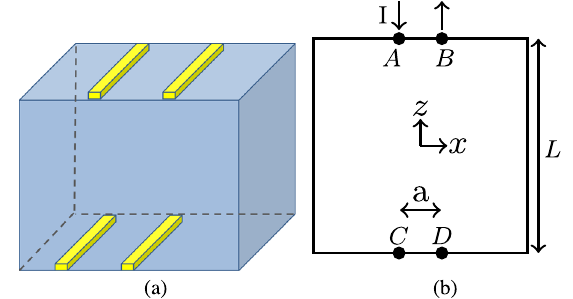
FIG. 6. (a) The dc setup. y direction extent is much larger than L . (b) x − z slice of the setup in (a). A current, I , is injected via contact A and withdrawn from contact B .